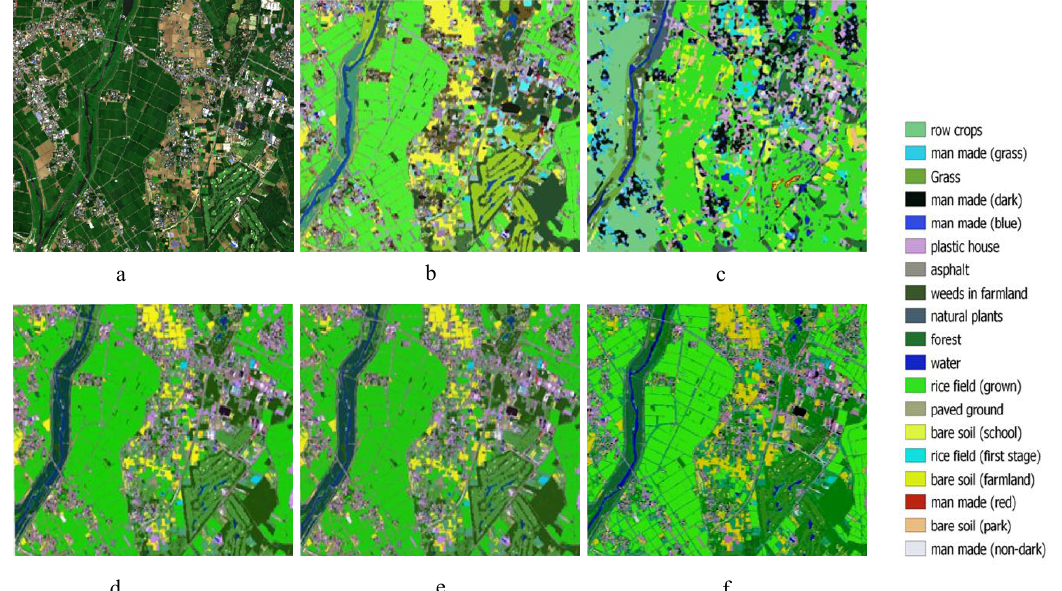
Figure 7 . The classification map for Chikusei data subset. a. Study area, b. The proposed model, c. 2D-CNN, d.3D-CNN, e. Support vector machine, f. Random forest.